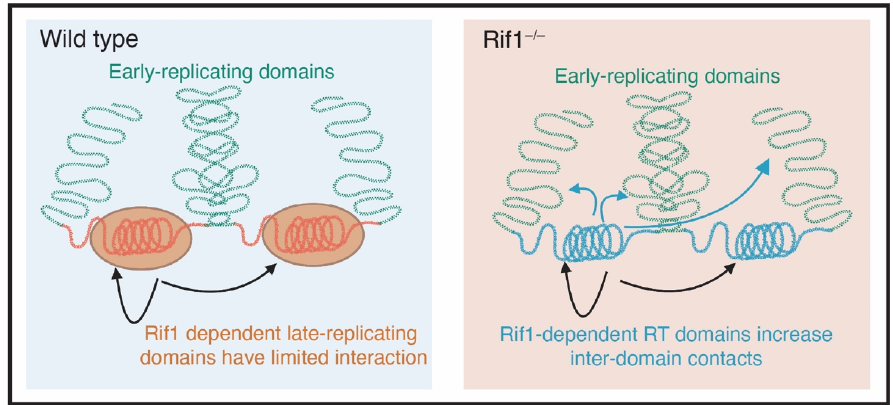
Figure 3. Rif1 mediates nuclear organization. In cells that are wild type for Rif1 (blue box), early and late replicating domains are separated from each other (green and red DNA respectively). The late replicating domains, which are coated with Rif1, have limited physical interactions. In cells that are mutant for Rif1 , there is an increase in physical interactions between genomic domains that depend on Rif1 to maintain their replication timing (Adapted from Foti et al., 2016 [65]).